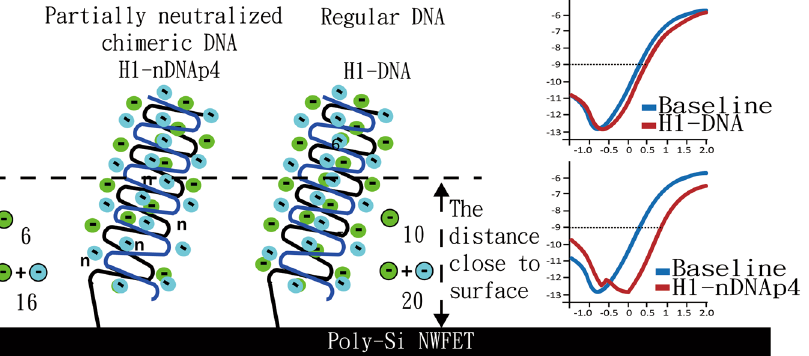
Figure 5. Charge variations adjacent to the surface of Si NW-FET chip before and after hybridization with the perfectly matched sequence. Small green and blue circles denote negative charges; the inserted I d − V g curves at the right side present the performances of two different